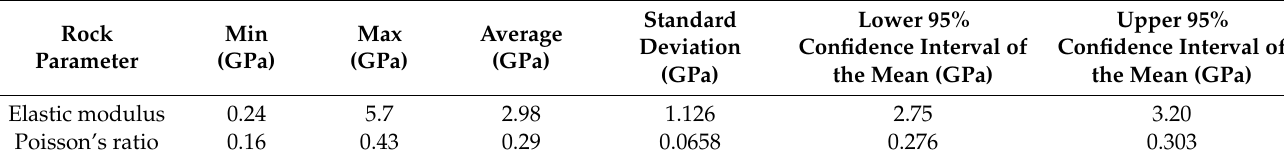
Table 1. Statistical table of the elastic modulus and Poisson’s ratio data of coal.